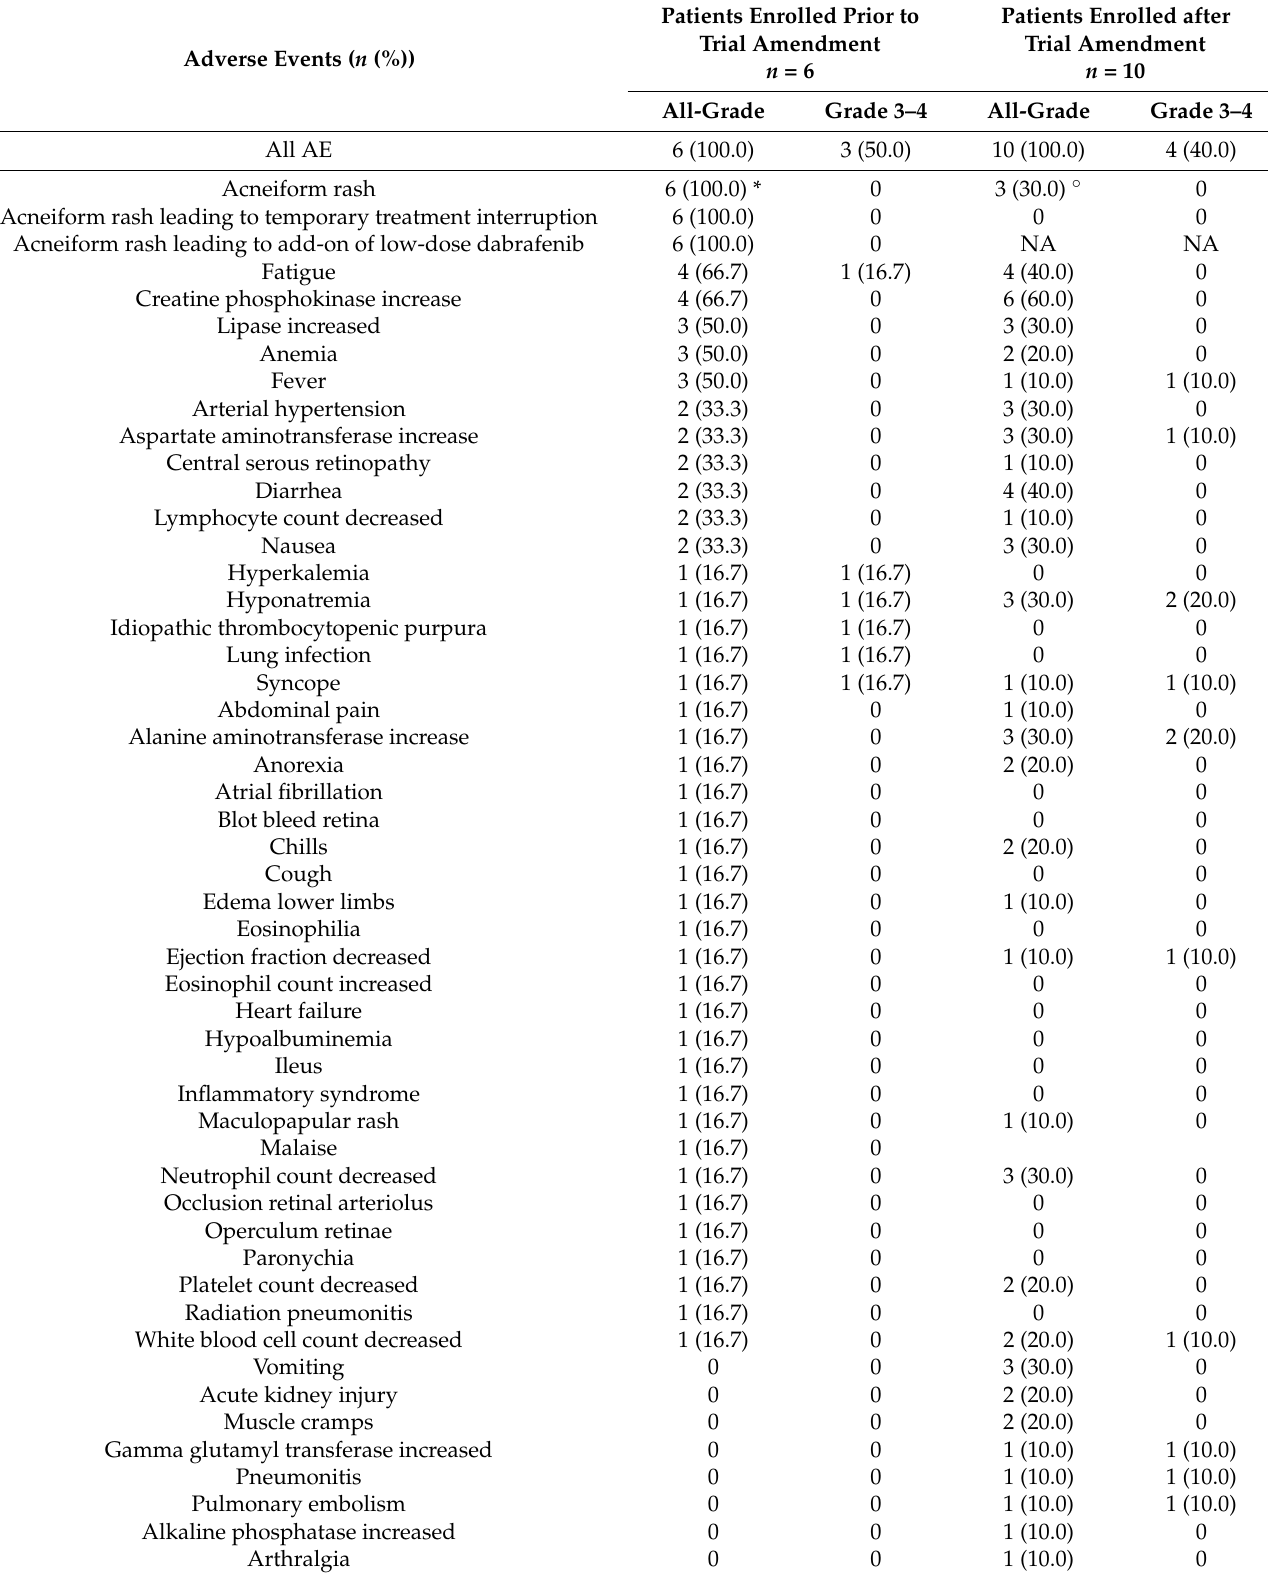
Table 2. Adverse events in patients enrolled prior to the trial amendment ( n = 6) and in patients enrolled after the trial amendment ( n =